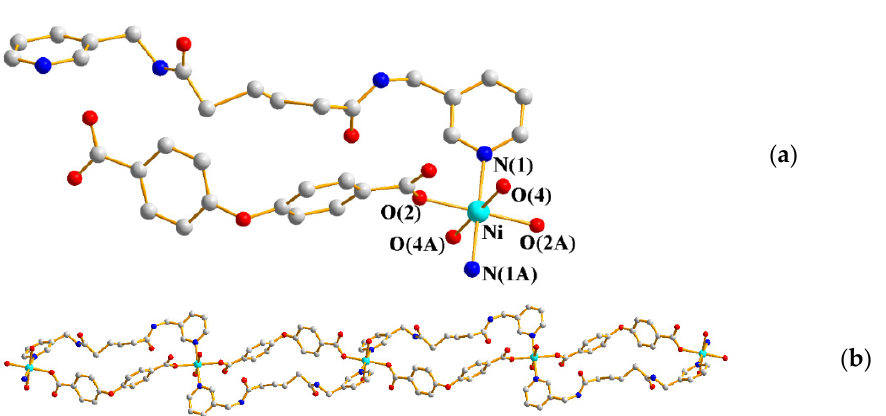
Figure 6. ( a ) Coordination environment of Ni(II) ion in 7 . Symmetry transformations used to gener- equivalent atoms: (A) x + 1/2, − y + 3/2, − z. ( b ) A drawing showing the 1D ate equivalent atoms: (A) x + 1/2, − y + 3/2, − z. ( b ) A drawing showing the 1D structure.